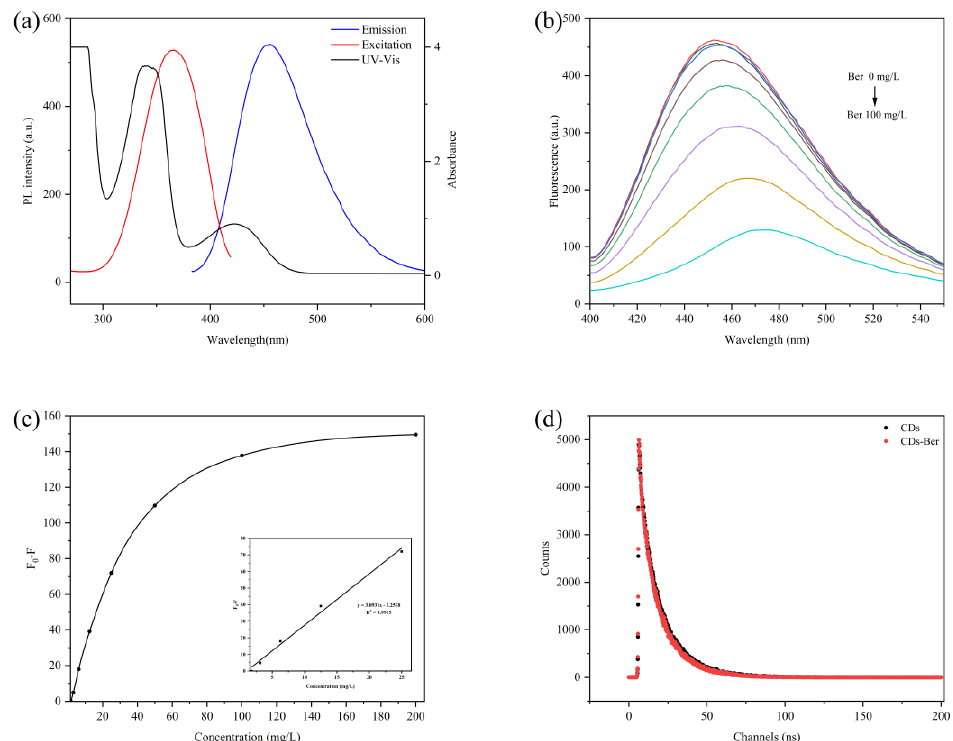
Figure 4. ( a ) UV-Vis absorption spectra of berberine (black line) and excitation (red line) and emission spectra (blue line) of CDs. ( b ) Fluorescence response spectra of CDs to different concentrations of berberine. ( c ) Fluorescence changes of different concentrations of CDs combined with berberine. Insets: linear diagram of berberine concentration. ( d ) Fluorescence lifetime of CDs (black line) and CDs-Ber (red line).